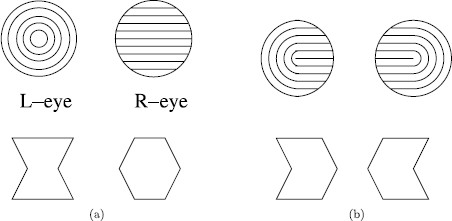
Percepts for Suzuki and Grabowecky [15]